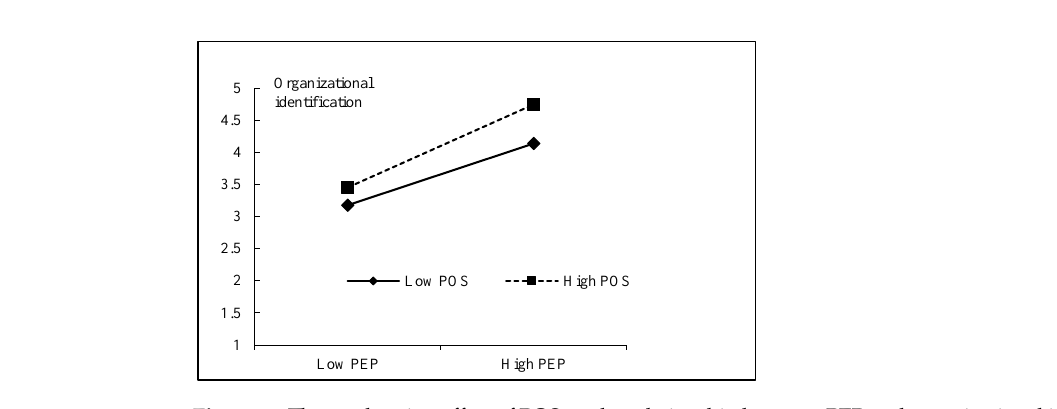
Figure 2. The moderating effect of POS on the relationship between PEP and organizational identi- fication. Table 7. Results for conditional indirect effects.